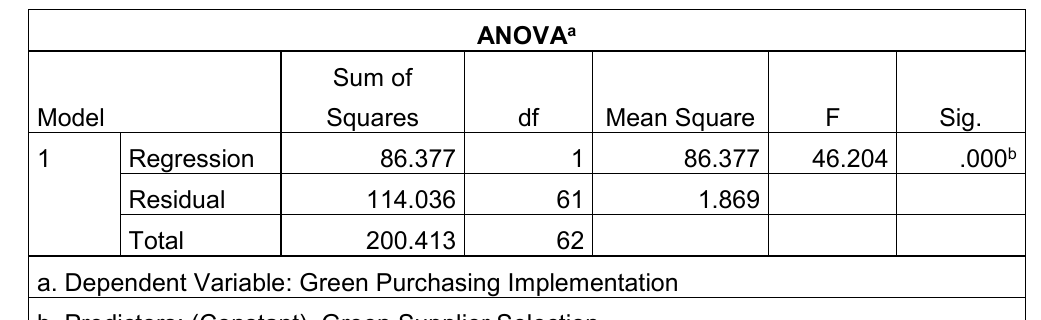
Table 3. Test Results